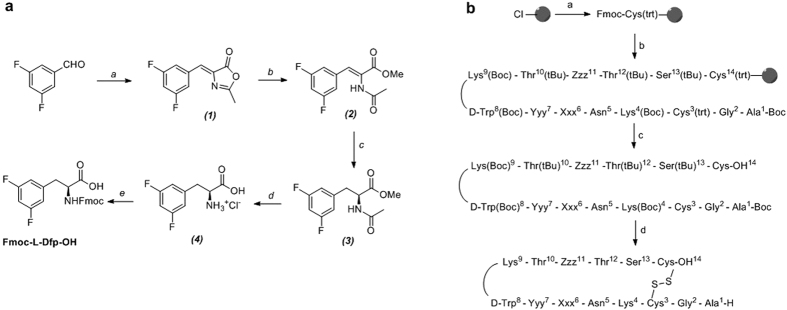
Schematic representations of the Dfp synthesis and the synthetic protocol used for the preparation of peptides 1–6.(a) Synthesis of Fmoc-L-Dfp-OH. a) N-Ac-Gly-OH, AcONa, Ac2O, 2 h, 100 °C; b) MeONa, MeOH, 2 h, 70 °C; c) [Rh(S-MaxPHOS)(COD)]BF4 cat 3%, H2 (5 bar), MeOH, r.t.; d) HCl aq, 6 h, reflux; e) FmocOSu, Na2CO3, H2O, acetone, 0 °C to r.t.; (b) General schematic synthesis pathway for peptides. a) 1. Fmoc-L-Cys(trt)-OH (3 eq.), DIPEA (4 eq.), 2. MeOH; b) 1. Piperidine 20% DMF, 2. Fmoc-Aaa-OH (1.5–3 eq.), DIPCDI (3 eq.), HOBt (3 eq.), DMF, c) CH2Cl2/TFE/AcOH, d) 1. I2, 2. TFA/CH2Cl2/anisole/H2O.